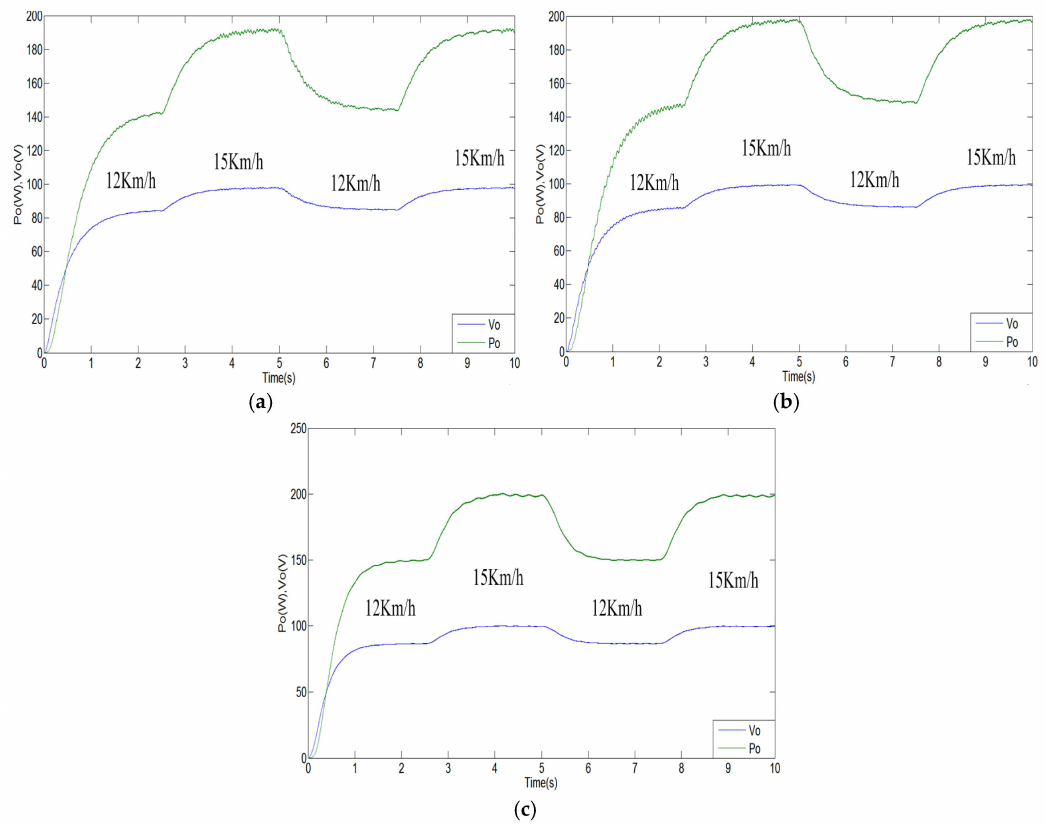
Figure 8. Simulation results of different control method: ( a ) P&O; ( b ) extremum seeking control (ESC); and ( c ) ESMC.